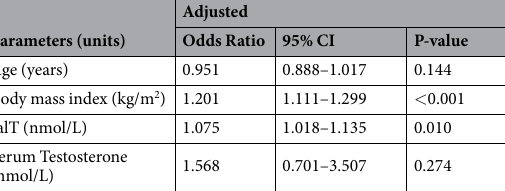
Table 5. Multiple logistic regression analysis for the androgen prediction of PCOS including age, body mass index, salivary testosterone and serum testosterone. Logistic regression taking into account age and body mass index (BMI) showing that in this model salivary testosterone (salT) is significantly more predictive of PCOS than the free androgen index (FAI) or serum T (Tables 5 and 6, respectively), and that FAI was more predictive than serum T